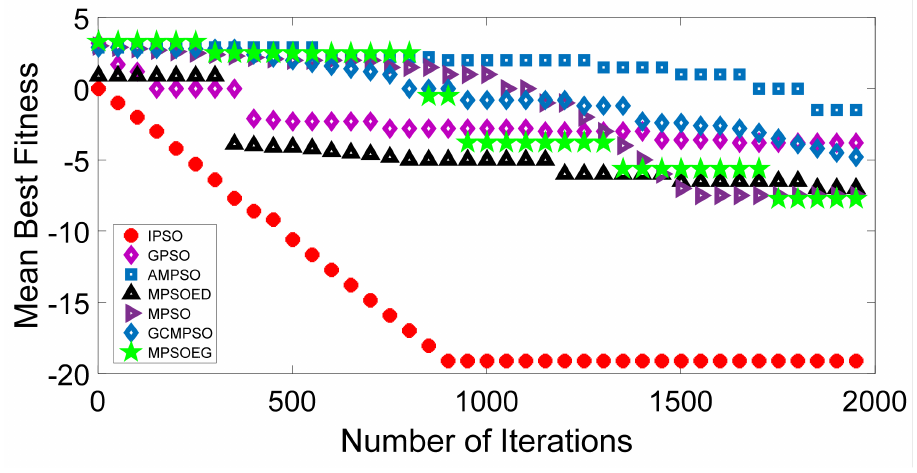
Figure A6. Algorithms’ convergence plots on f 9 .